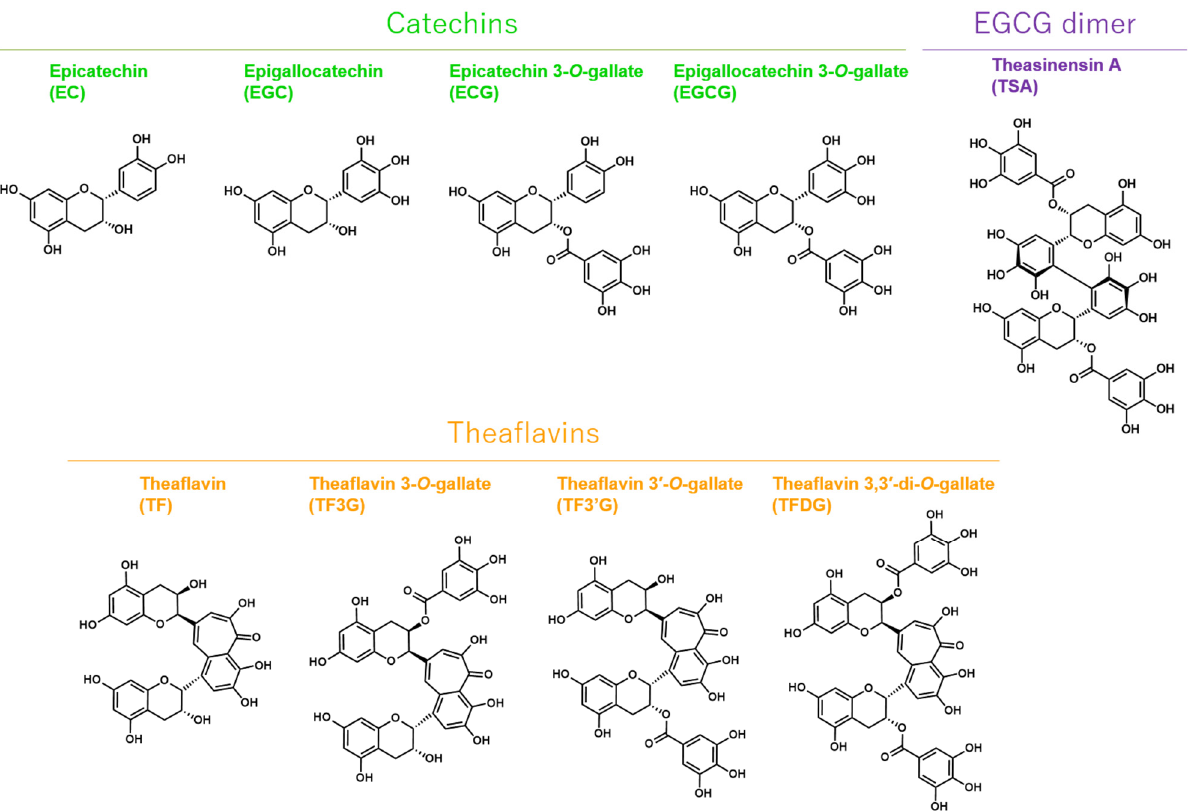
Figure A2. Chemical formulae of the compounds used in the study. Table A1. Concentrations ( µ M) of catechins, theaflavins, and EGCG dimers in the indicated tea used in this study.